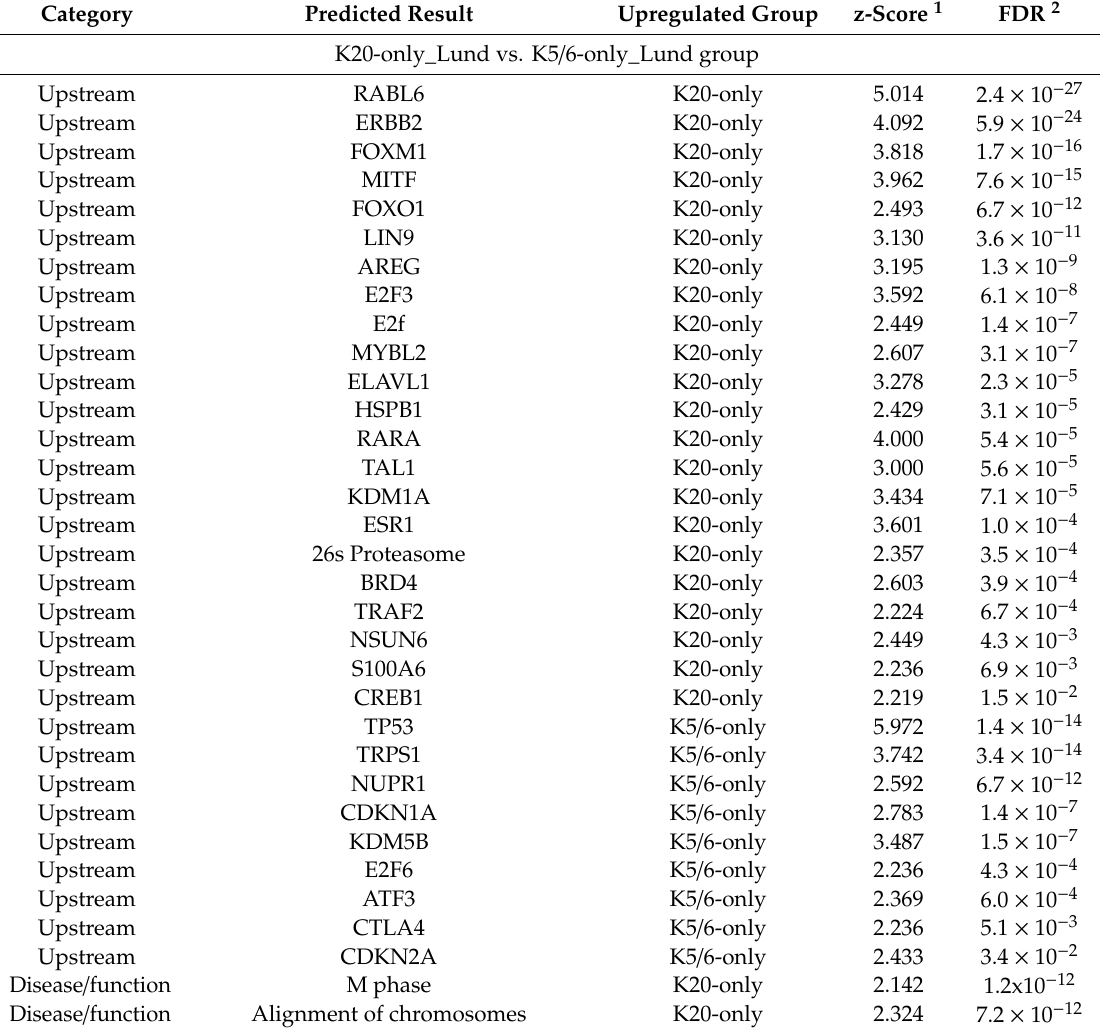
Table 2. Significant functional enrichment of the Lund groups predicted by Ingenuity Pathway Analysis.